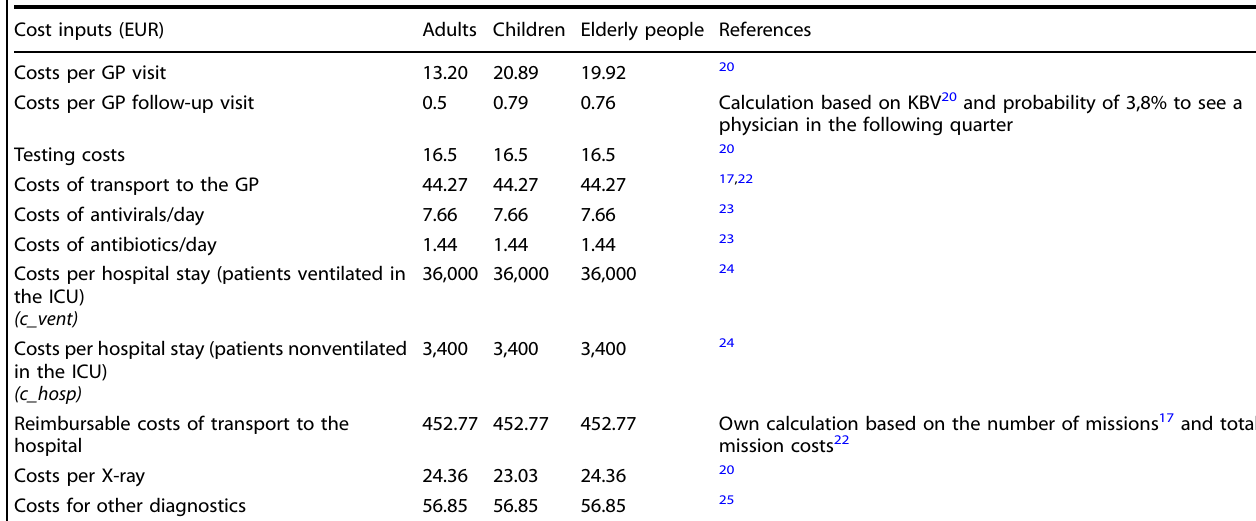
Table 2. Cost inputs.